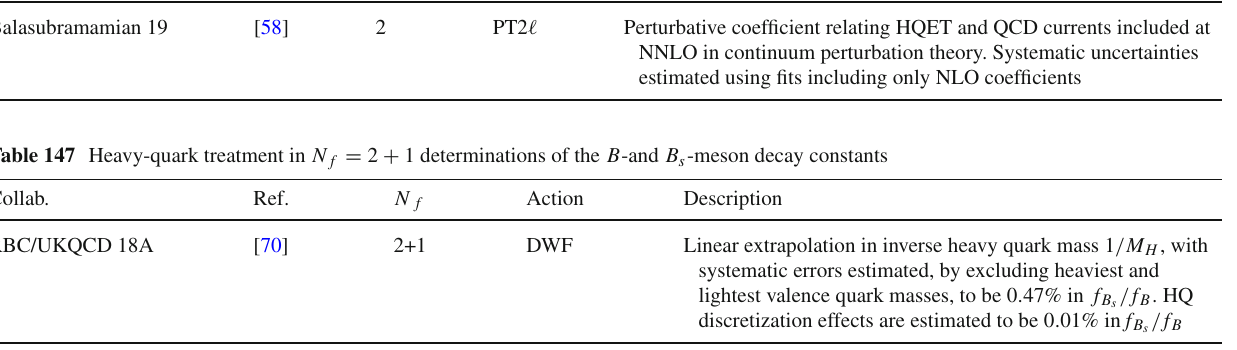
Table 146 Description of the renormalization/matching procedure adopted in the determinations of the B - and B s -meson decay constants for N f = 2 simulations Collab.